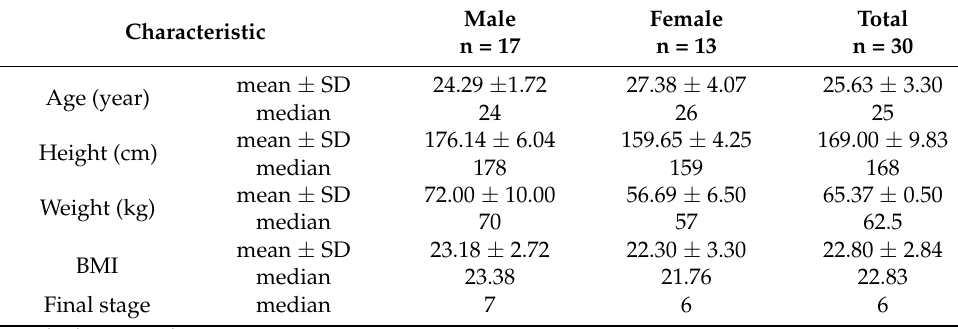
Table 1. The phenotype information of all